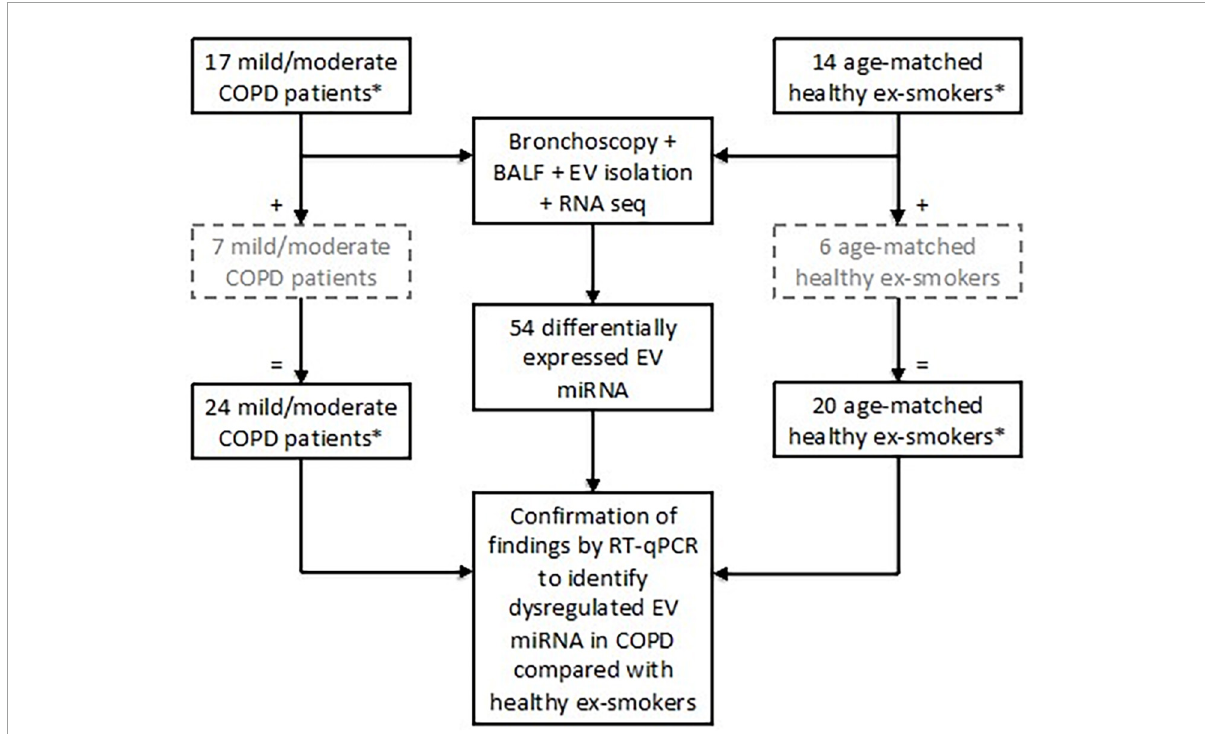
FIGURE1 Subject enrolment and tests performed in the study to assess extracellular vesicle (EV) microRNA (miRNA) expression. Subjects included in the grey, hashed boxes were recruited later and therefore only underwent testing for EV miRNA via RT-qPCR. ∗ All subjects were ex-smokers having given up smoking at least 6 months prior to study enrolment and with at least a 10-pack year smoking